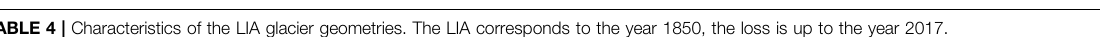
TABLE 4 | Characteristics of the LIA glacier geometries. The LIA corresponds to the year 1850, the loss is up to the year 2017. Bordu glacier Kara-Batkak glacier Sary-Tor